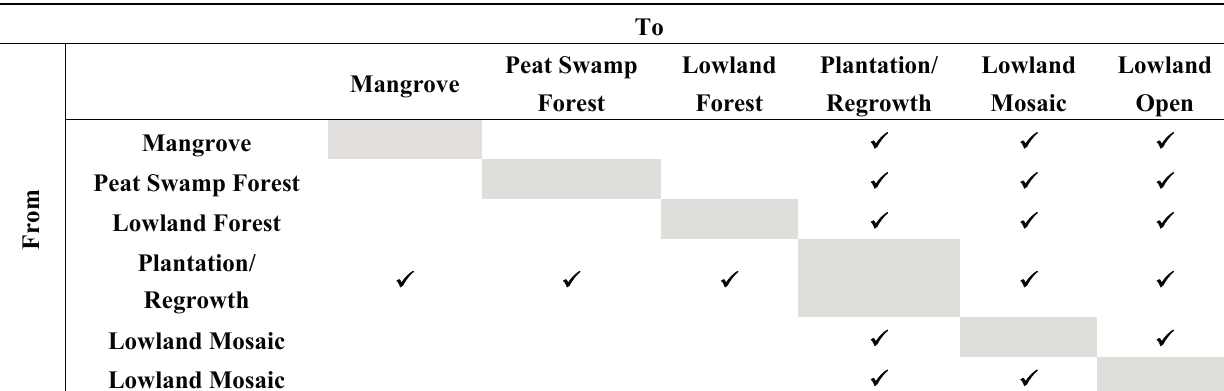
Table 3. Land cover transitions permitted in the